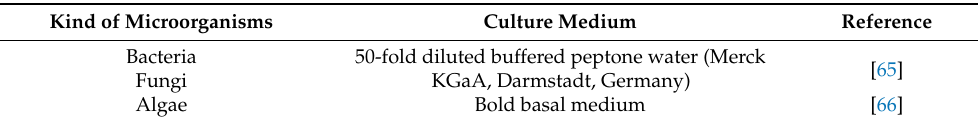
Table 4. Culture